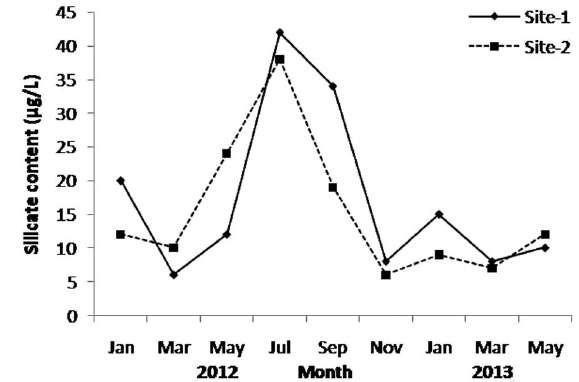
Fig. 6. – Seasonal variations in nitrate content of seawater at Site 1, Payyannur (PNR), and Site 2, Panambur (PNBR).